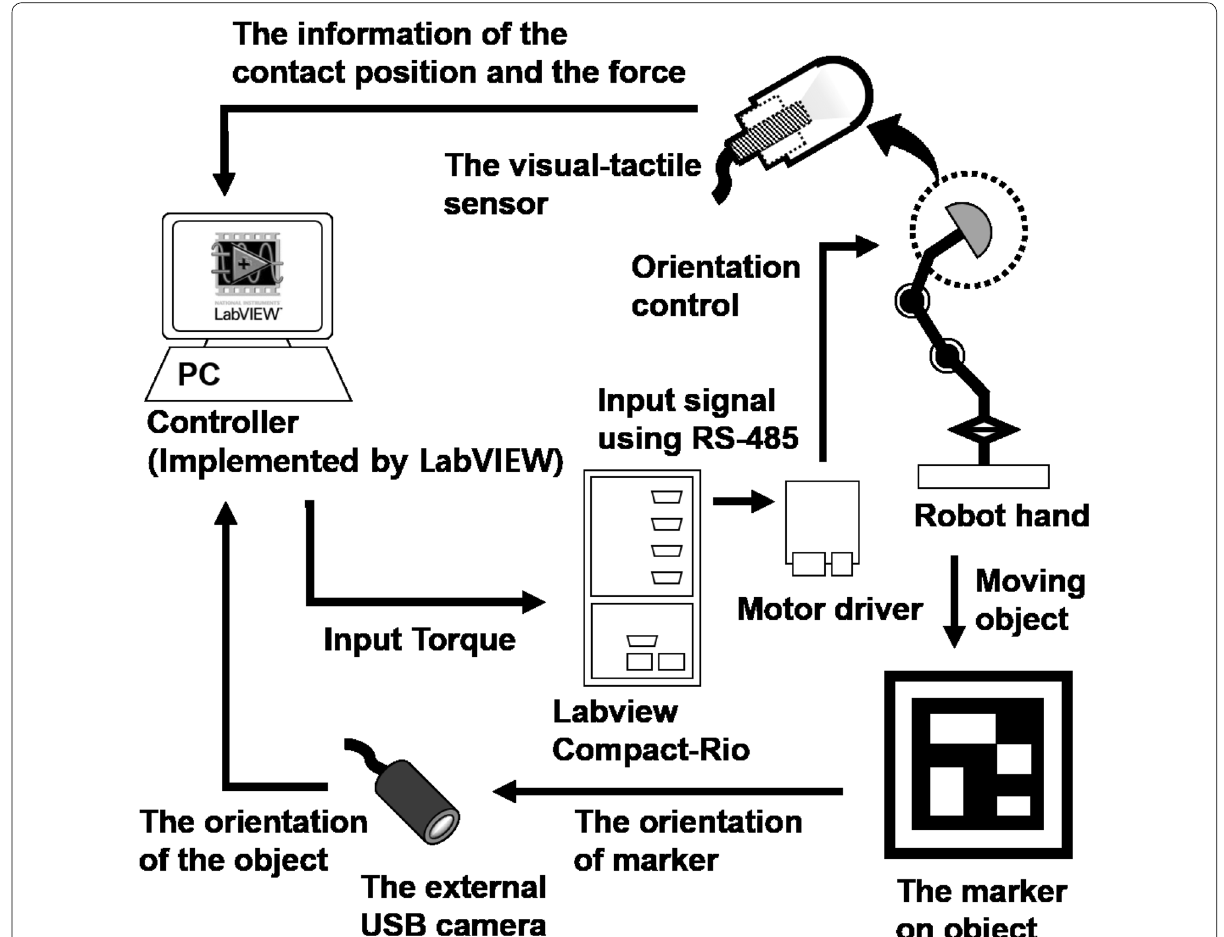
Fig. 19 Overall system for the manipulation